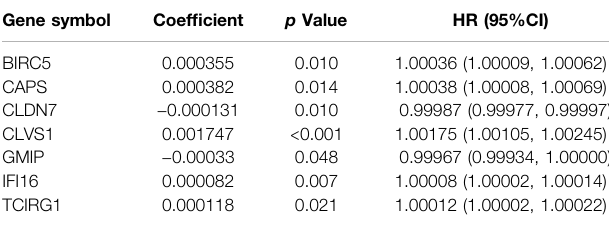
TABLE 1 | Multivariate cox regression of DEGs.